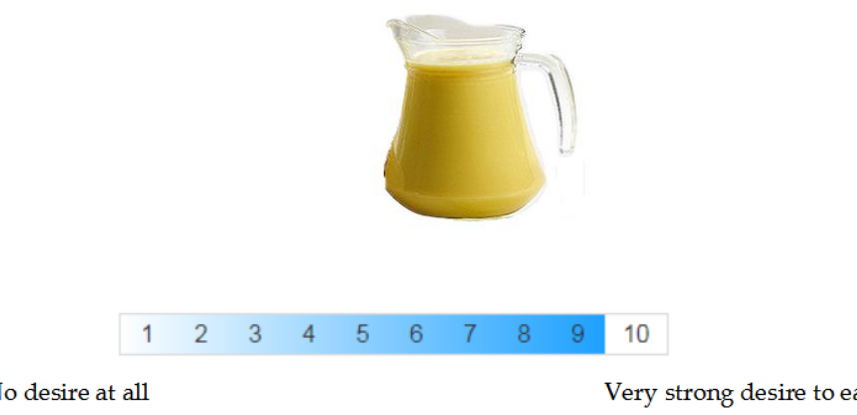
Figure A10. The picture of corn products (Liquid food).